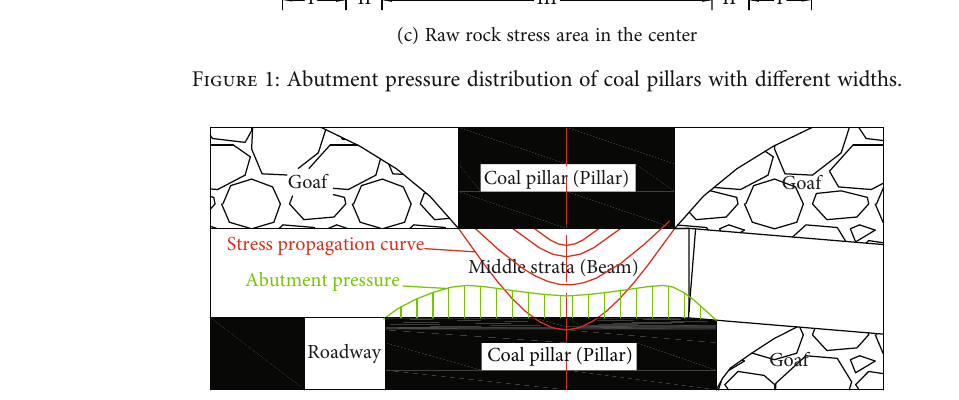
Figure 2: “ Column-beam-column ” superimposed coal pillar structure.